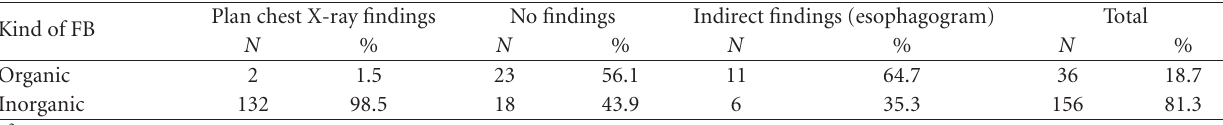
Table 3: Visibility of FB depending on its origin